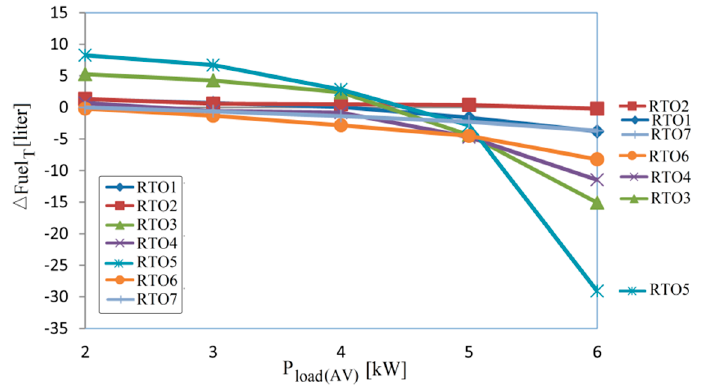
Figure 5. Fuel saving for k fuel = 0 and different P load(AV) .